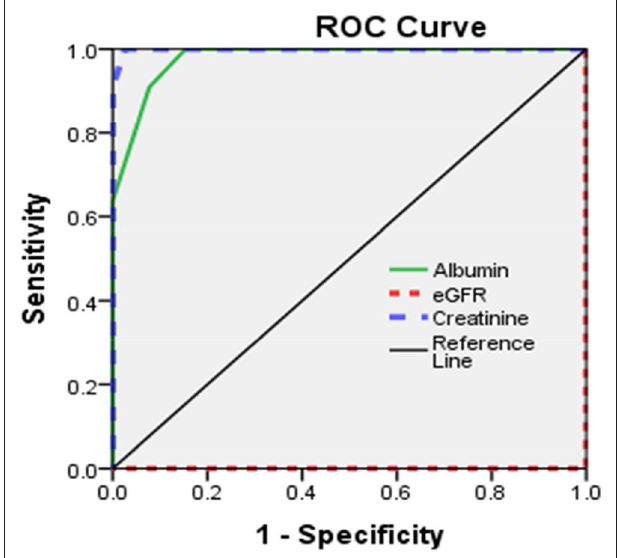
FIGURE 1 | Roc curve for eGFR, Albumin, and serum creatinine in relation to Peripheral neuropathy.